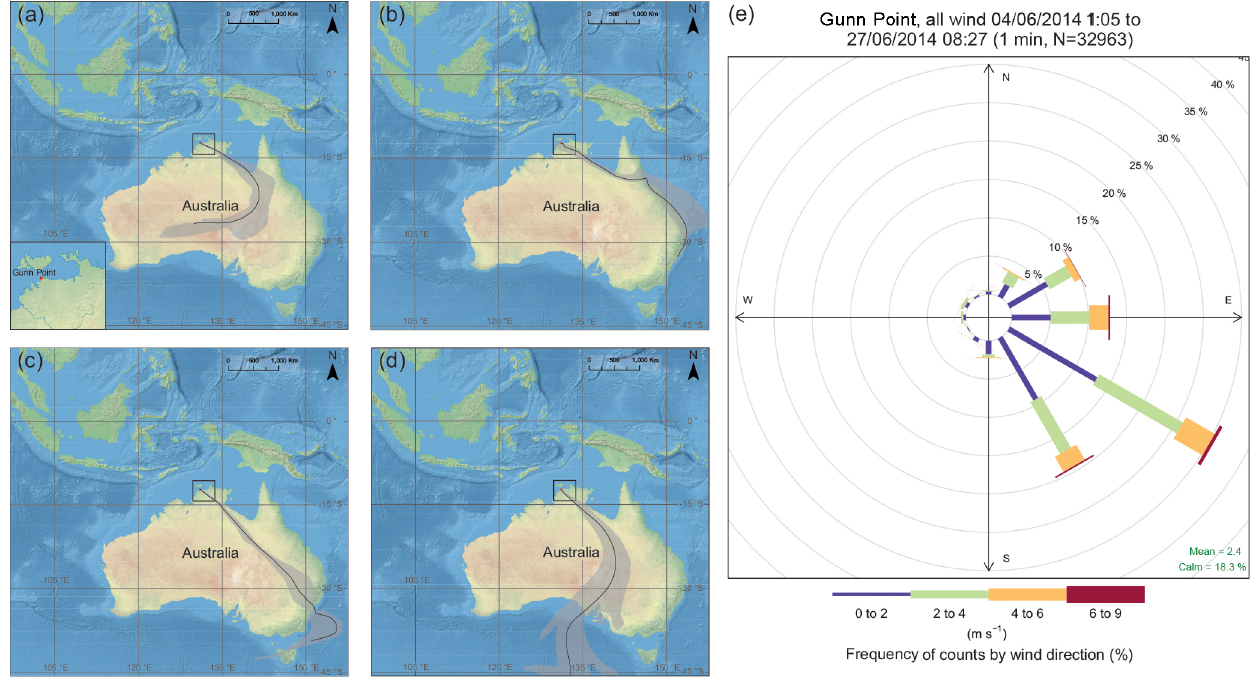
Figure 1. Location of Gunn Point study site. Insert of the Northern Territory showing the Gunn Point site and the predominant air mass fetch regions for the June 2014 Gunn Point campaign. (a) Inland, low population density. (b) Coastal, moderate urban/industrial activity. (c) Inland, major urban/industrial activity. (d) Southerly. (e) Wind rose corresponding to the aerosol sampling duration. Wind rose created using the OpenAir package in R (Carslaw and Ropkins, 2012; Carslaw, 2014).